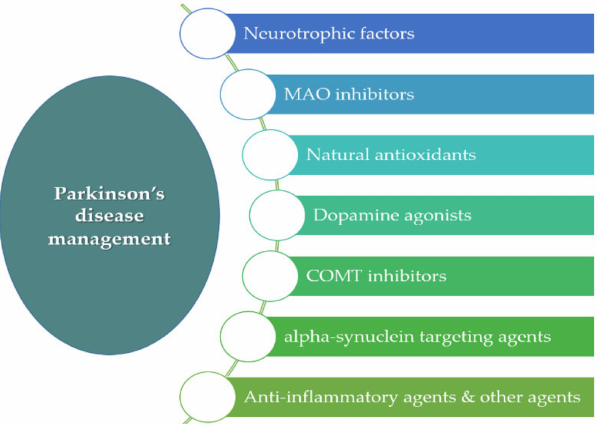
Figure 1. Antiparkinsonian agents under investigation encapsulated within polymeric micro- and nano-systems.